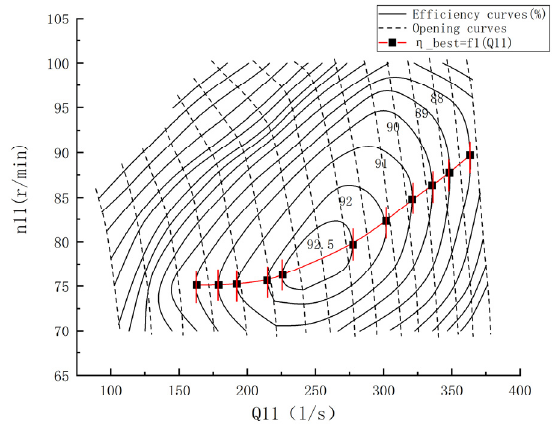
Figure 9. Hill diagram of the model pump-turbine.